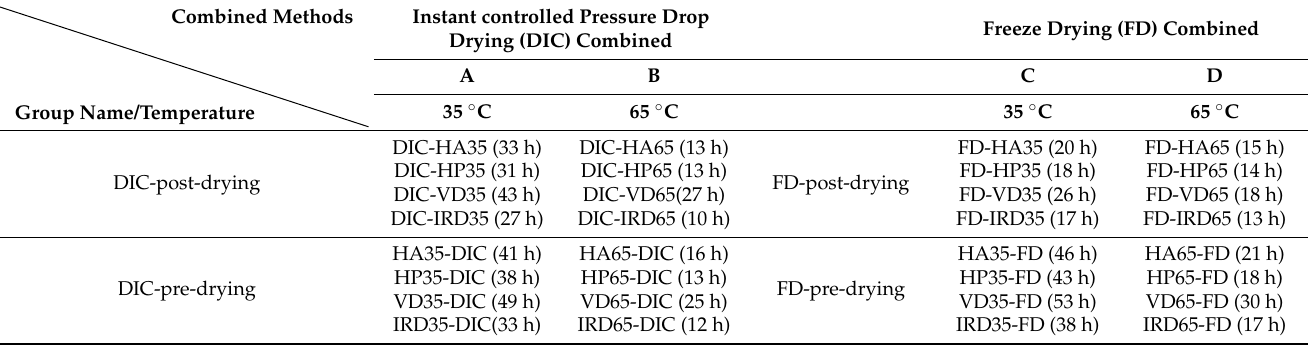
Table 1. Overview of the combined drying methods with applied temperature and drying time.